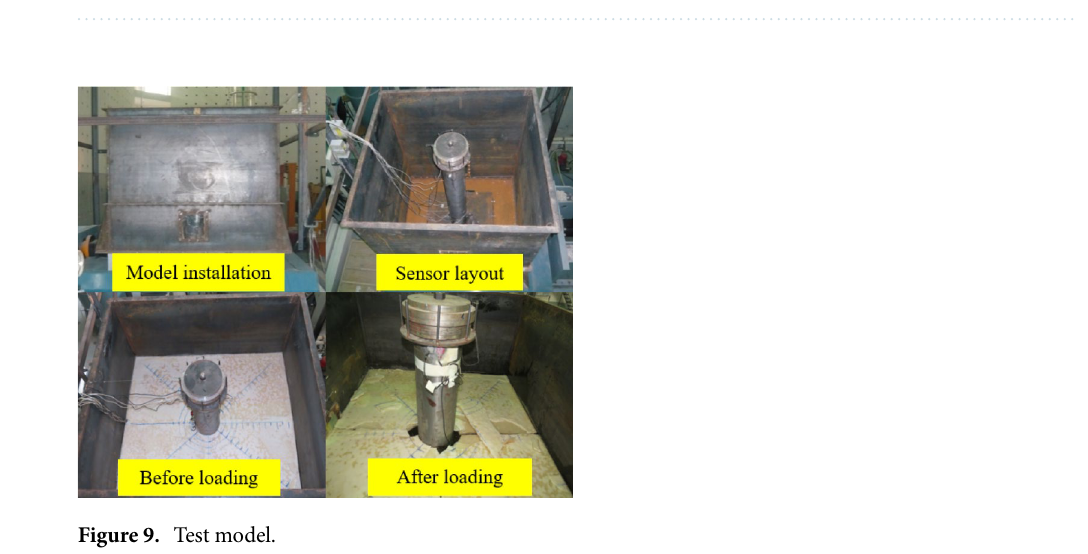
Figure 8. Change laws of the curvature with the PGA: ( a ) T1-II-1; ( b ) T2-II-1.